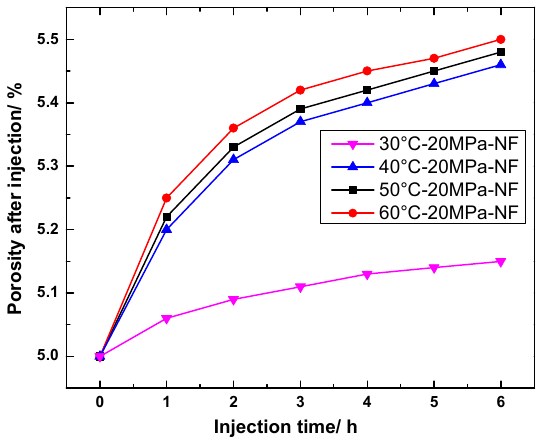
Figure 6. Variation in porosity with time for NF specimens at different temperatures under the same pressure of 20 MPa.